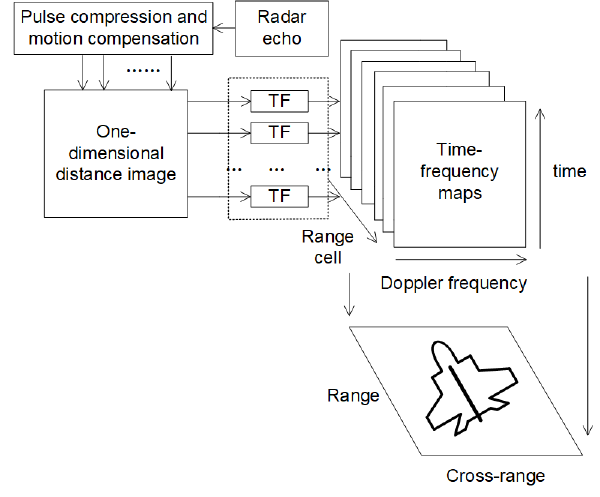
Figure 2. The process of ISAIL time-frequency